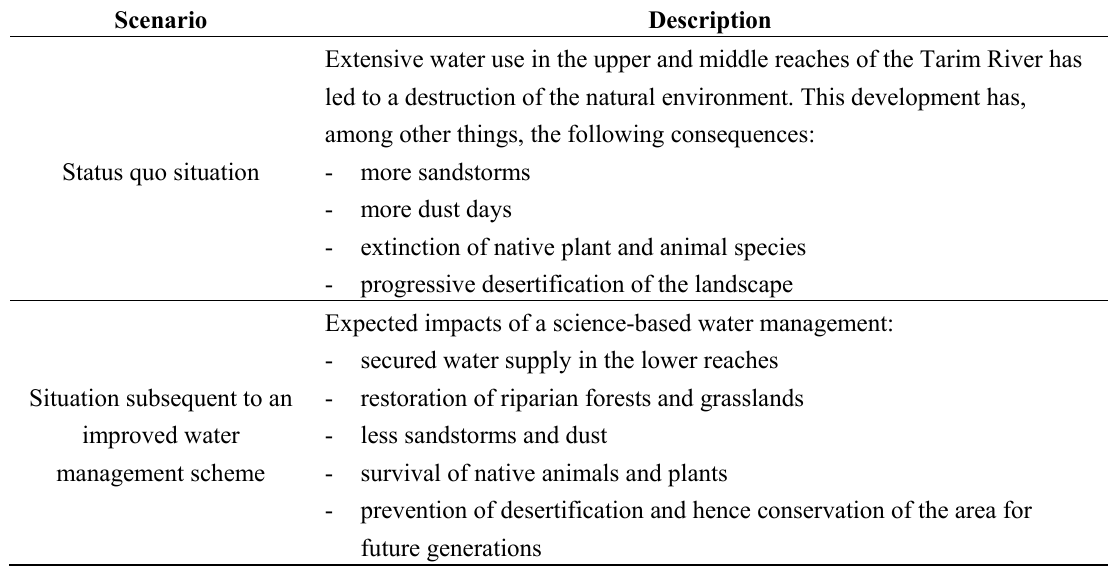
Table 2. Description of the environmental change resulting from a more sustainable water management.